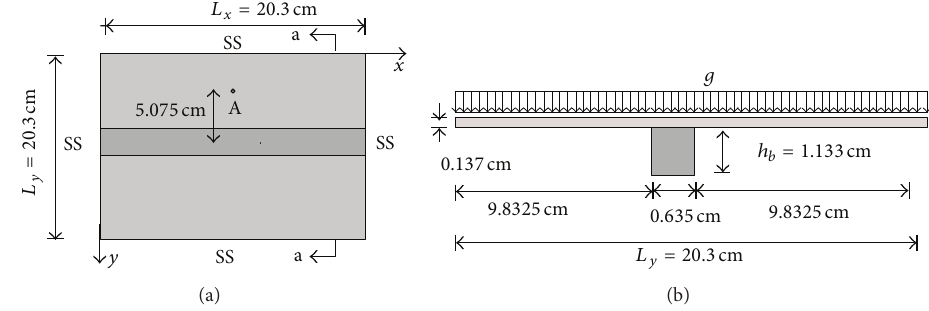
Figure 10: Plan view (a) and section a-a (b) of the stiffened plate of Example